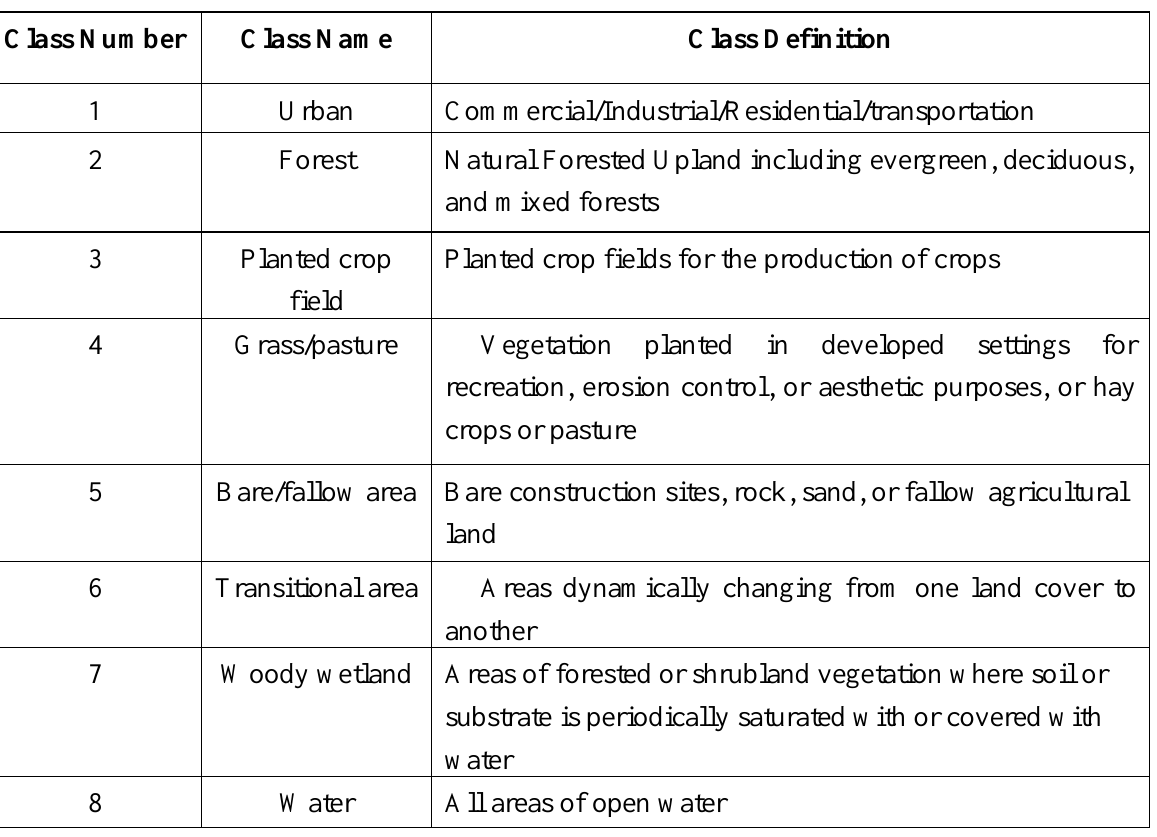
Table 1. Classification scheme and category